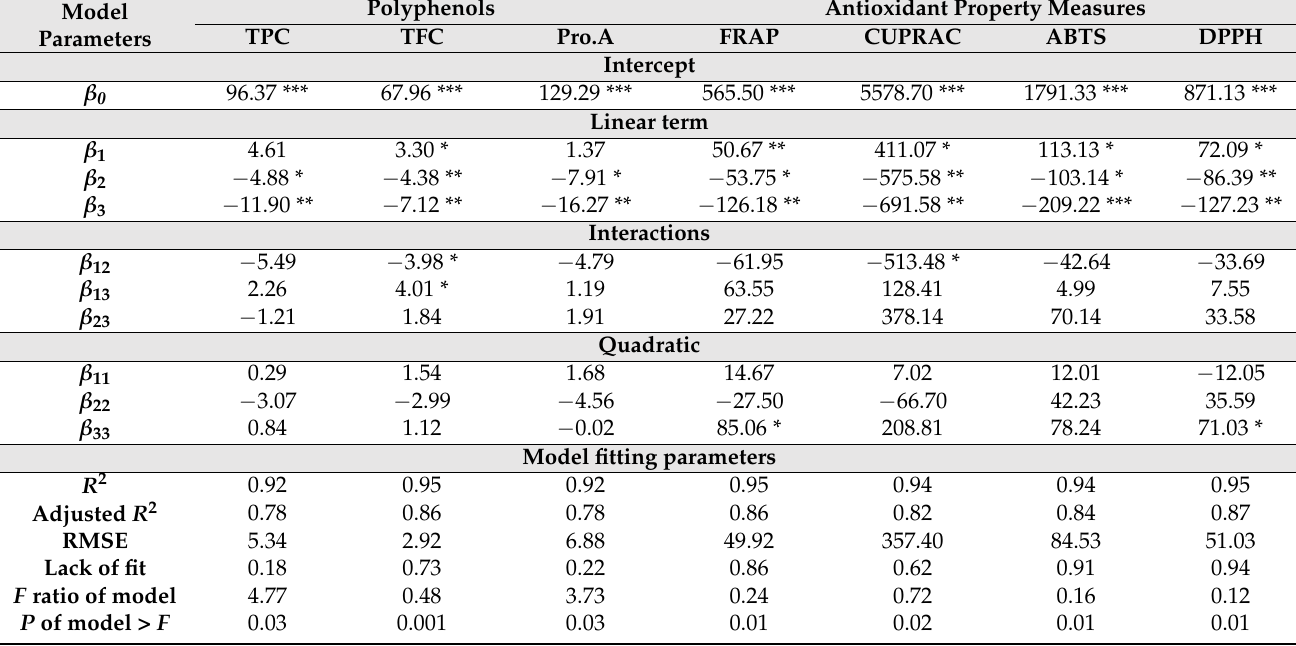
Table 2. Regression coefficients of the polynomial model and analysis of variance (ANOVA) results for prediction models